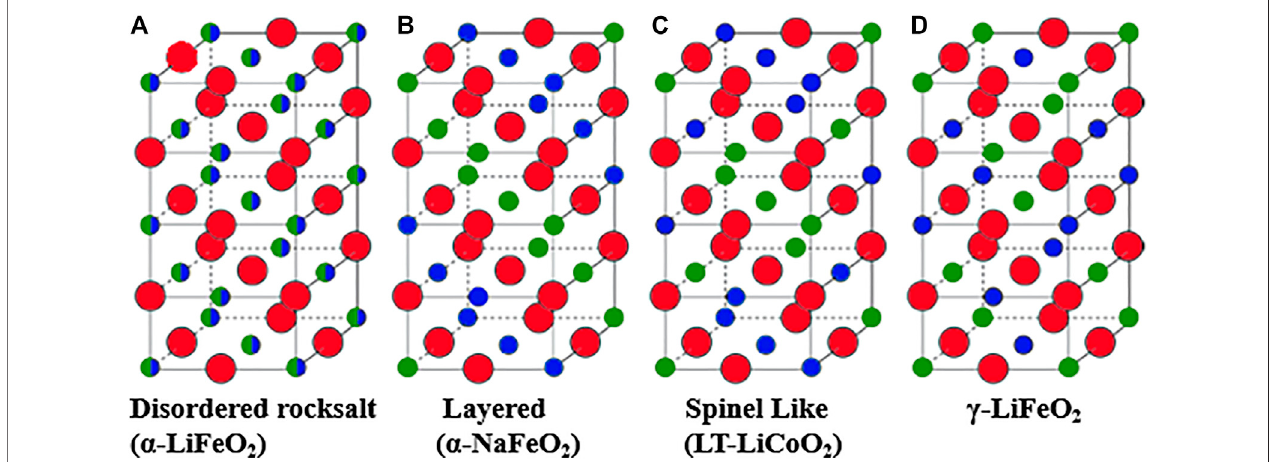
FIGURE6| Rocksaltlithiumtransitionmetaloxides: (A) disorderedrocksaltstructurewithequivalentcationsites, (B) layeredstructurewith α -NaFeO 2 structure, (C) low-temperature spinel-like LiCoO 2 structure,and (D) γ -LiFeO 2 structure.Oxygenisindicatedbyred circlesand Liand TMareindicatedbysmallgreenandblue circles. Adapted with permission from Urban et al. (2014), Copyright Wiley-VCH.